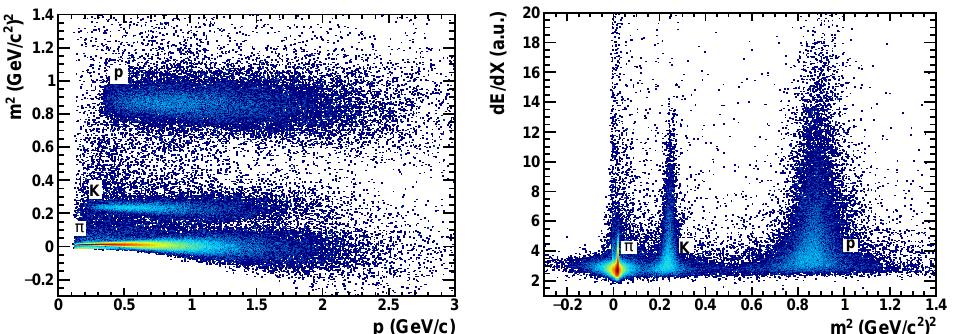
Figure 4. ( left ) Momentum dependence of mass-squared ( m 2 ) of charged particles. ( right ) dE/dx vs. m 2 for combined system Time-Projection Chamber (TPC) + Time-of-Flight (TOF) for charged hadrons with momentum 0 < p < 3 GeV/c.